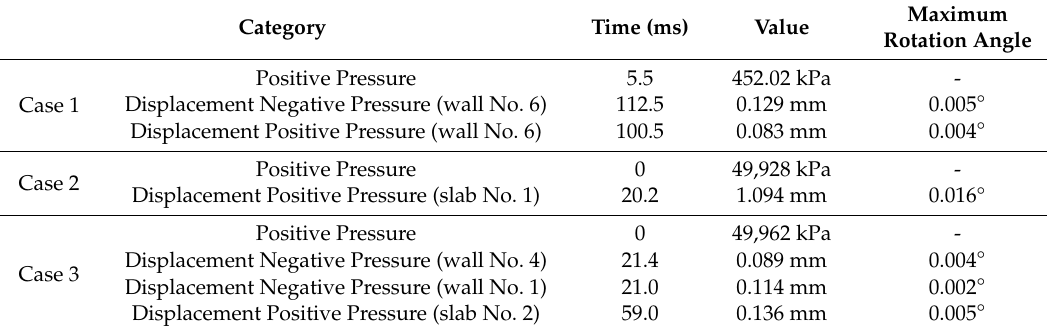
Table 3. Summary of FE Analysis